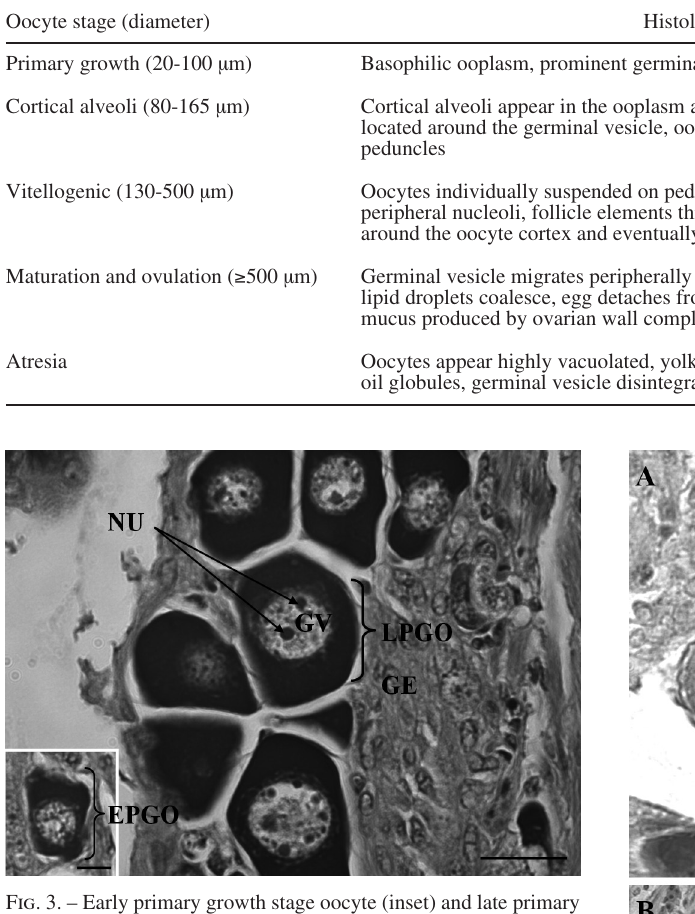
Table 1. – Key cytological features characteristic of lionfish oocytes.